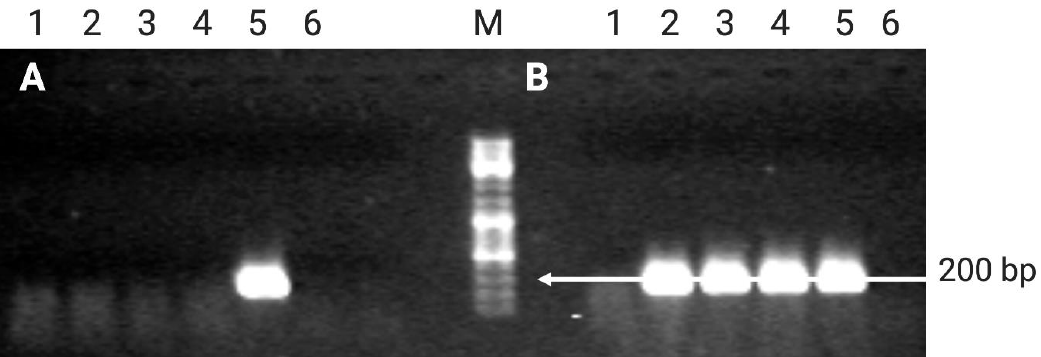
Figure 5. RT-PCR amplification on total RNA of ( A ) CaMV promoter and ( B ) GUS gene sequence from transformed and untransformed A. oleracea regenerated plants. 1: A. oleracea untransformed control; 2: A. oleracea pBI121_1 transgenic line; 3: